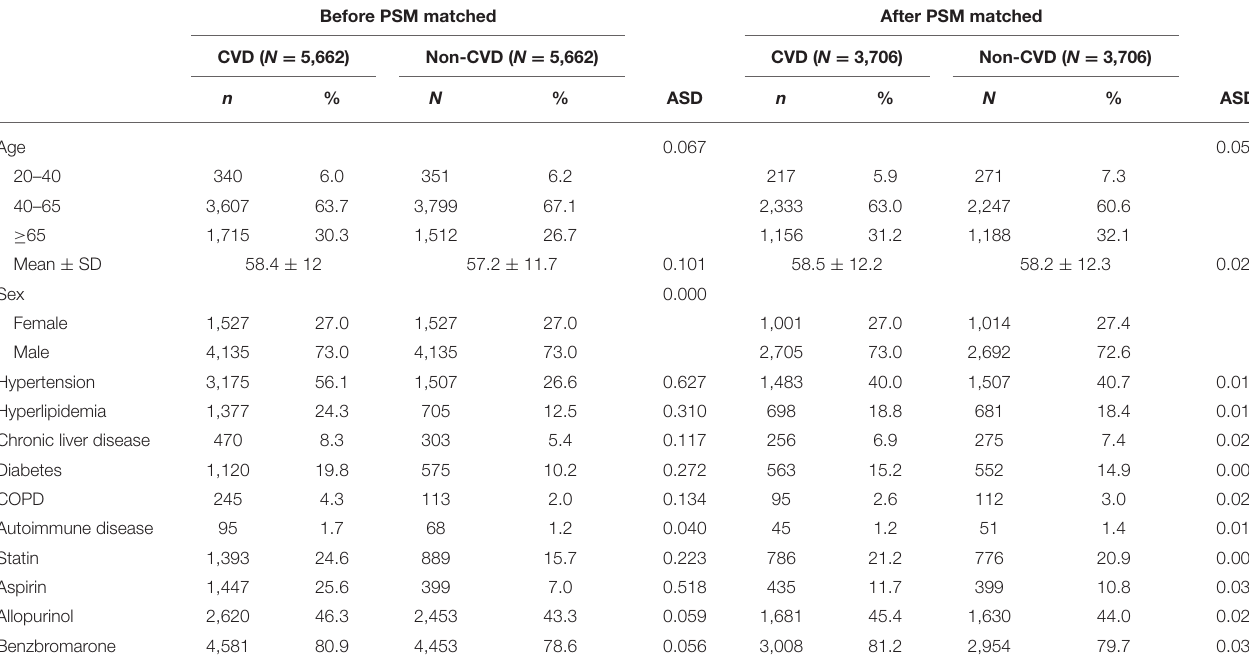
TABLE 1 | Demographic characteristics.